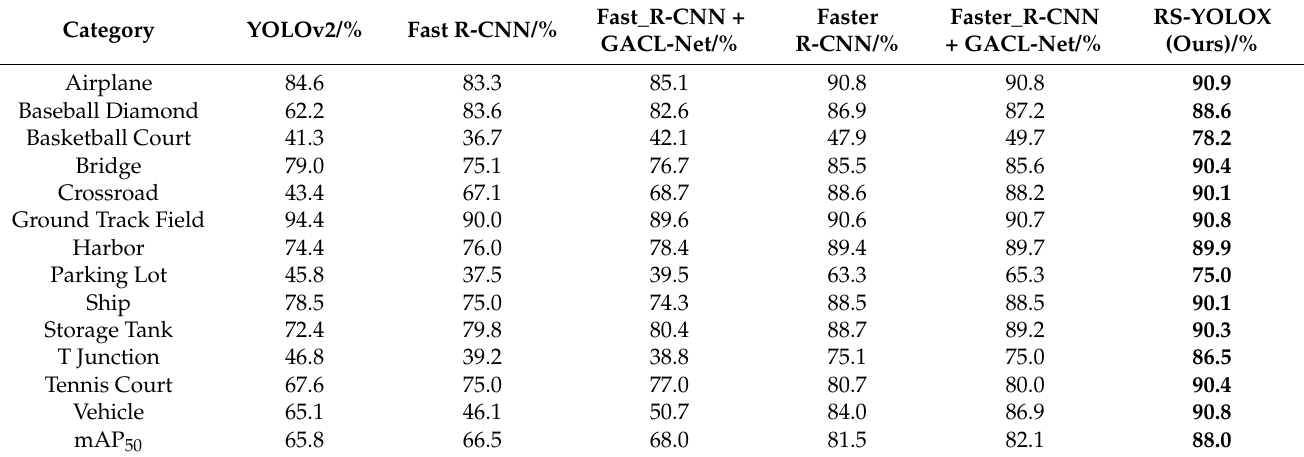
Table 6. Comparison of our model with the models on the HRRSD official